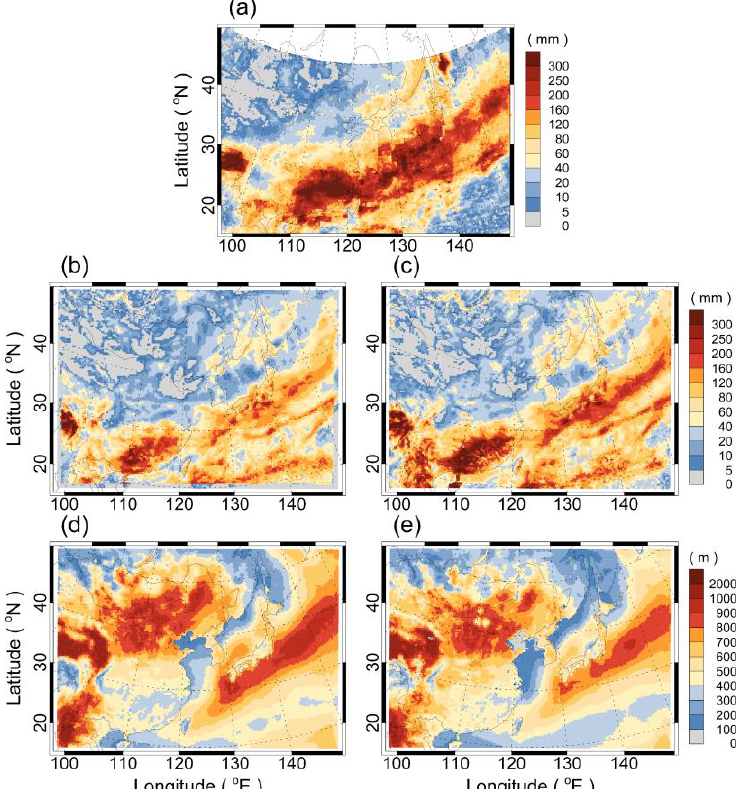
Figure 4. The spatial distributions of monthly precipitation in April 2010 estimated by ( a ) Tropical Rainfall Measuring Mission (TRMM) and simulated by ( b ) WRF-Chem and ( c ) WRF / CMAQ. The spatial distributions of the monthly mean planetary boundary layer (PBL) height simulated by ( d ) WRF-Chem and ( e ) WRF / CMAQ.